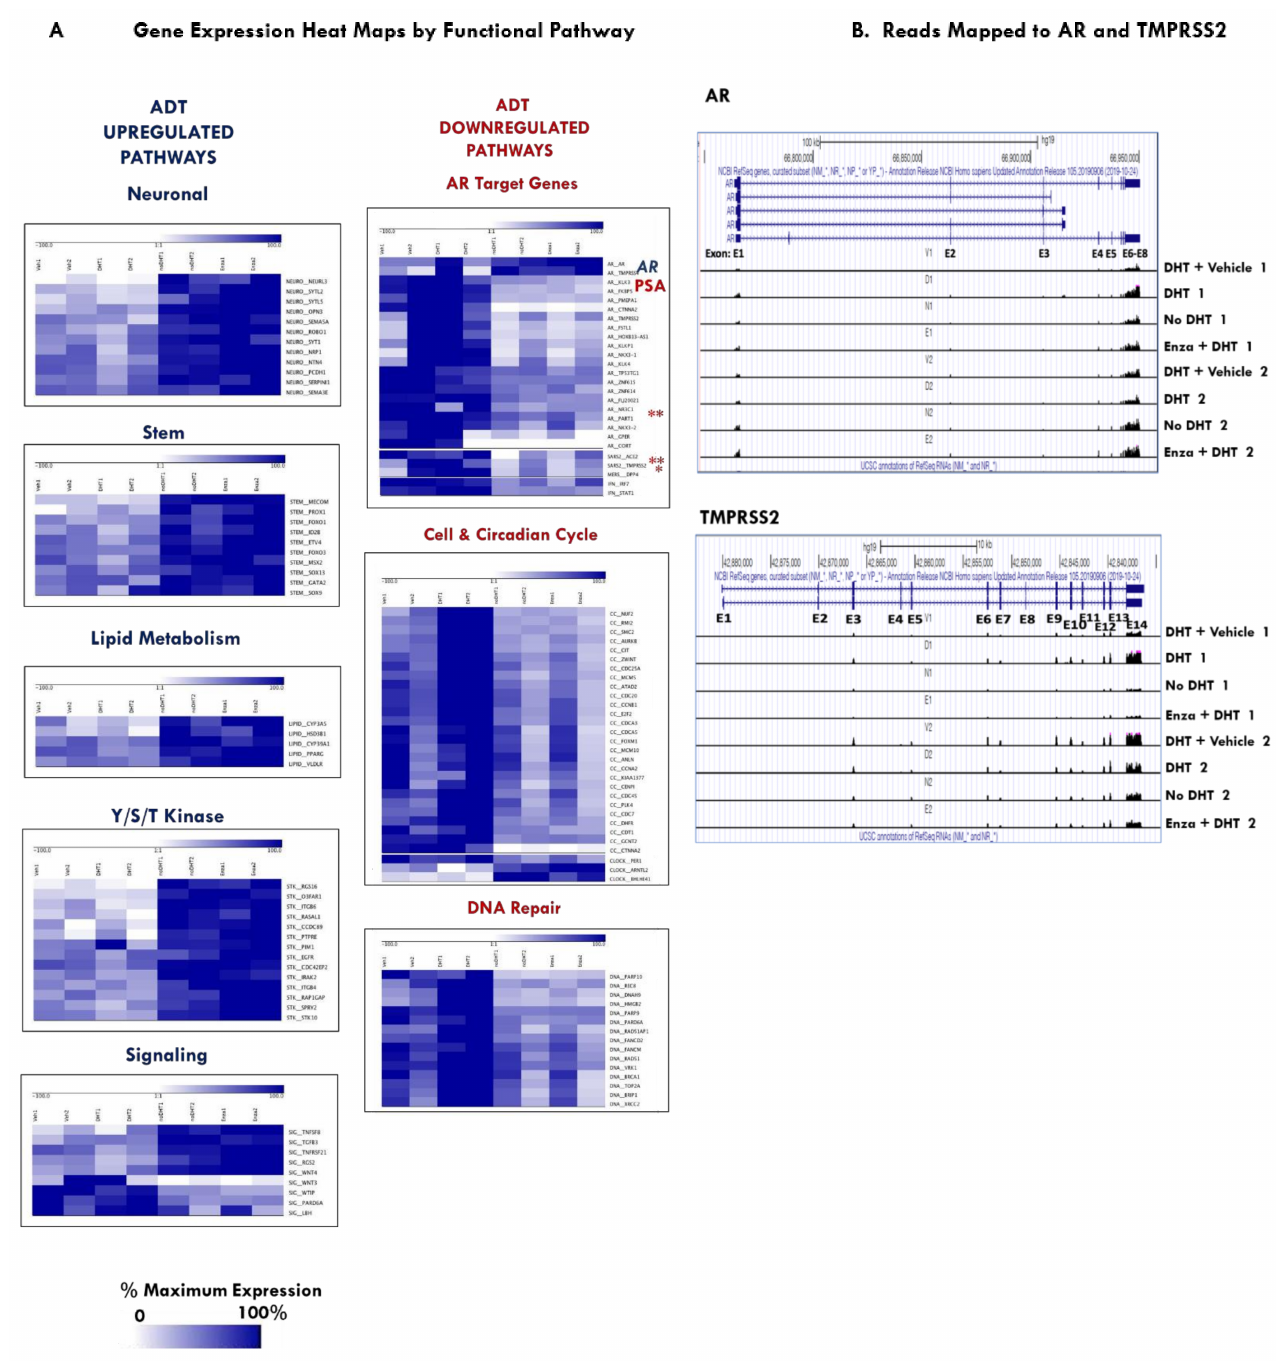
Figure 3. APDT up-regulated and down-regulated genes grouped by functional pathways. ( A ) Genes were clustered as percentage of maximum expression in functional classes and further classified